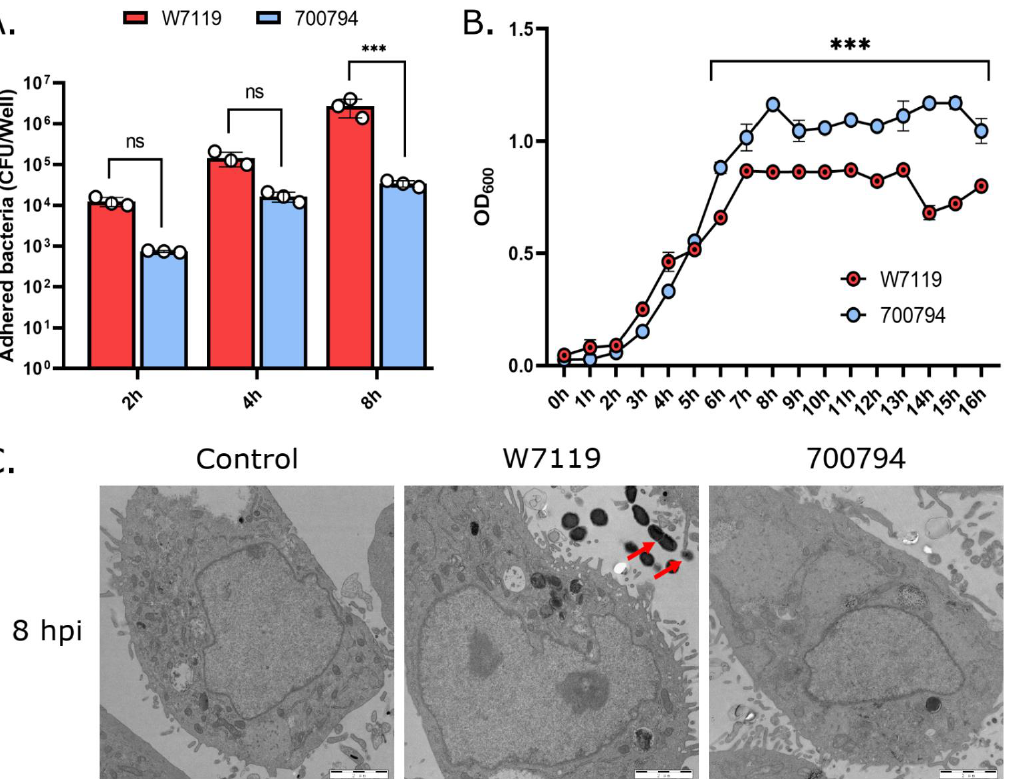
Figure 1. Adhesion to PAM-Tang cells by virulent and avirulent S. suis . ( A ) PAM-Tang cells were infected with S. suis vir-700794 or S. suis avir-W7119 (MOI = 1) for 2, 4, or 8 h. The white circles represent three replicate wells. ( B ) The growth of the two strains was tested in THB medium, with OD 600 values measured every hour. ( C ) Electron micrographs of PAM-Tang cells at 8 h post-infection (hpi) with virulent or avirulent S. suis . Ultrathin section, scale bar = 2 μm. Red arrows showed S. suis . All treatments were carried out in triplicate and experiments were repeated at least three times, results are expressed as means ± S.D, two-way ANOVA used to analyze the data; ns: not significant; ***: p < 0.001.